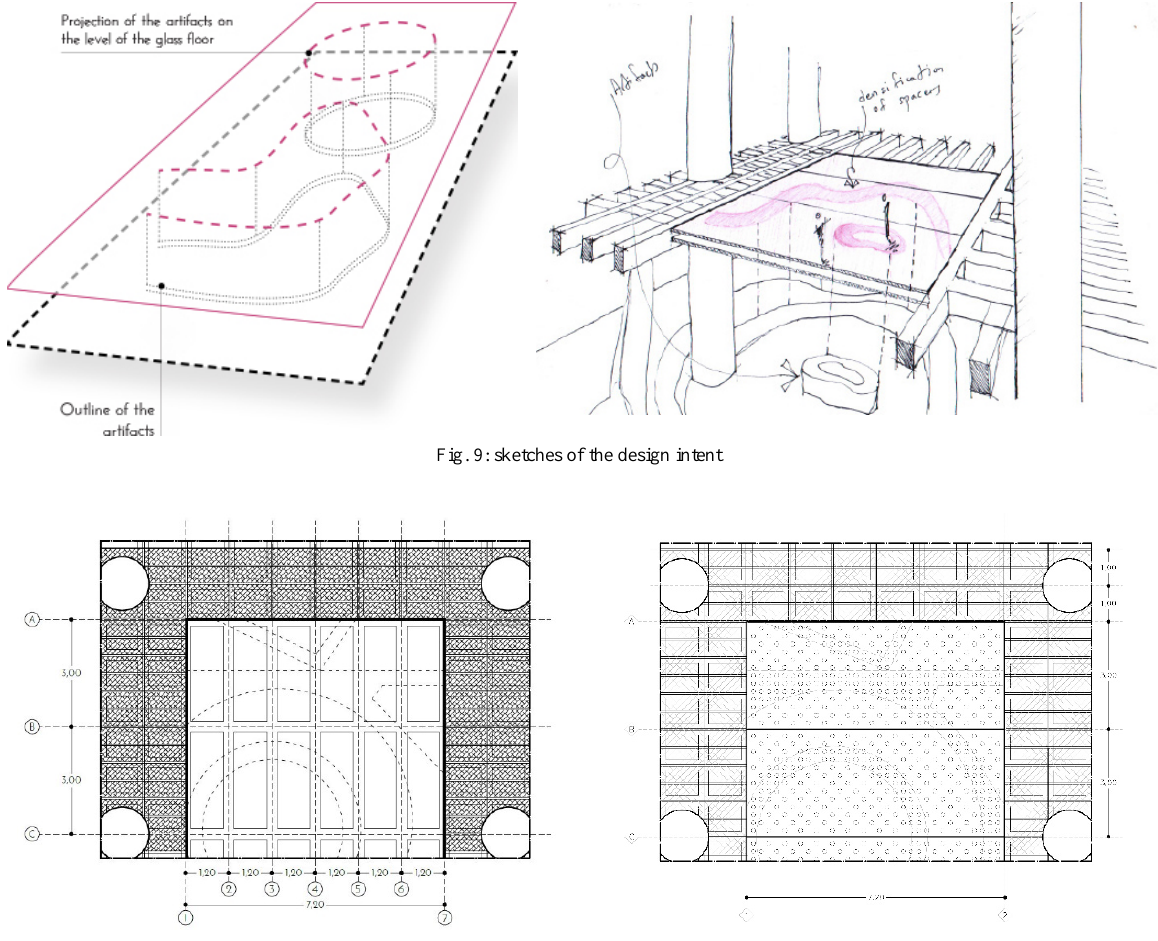
Fig. 10: transformation. Left: existing situation, Right: sandwich panel with spacer